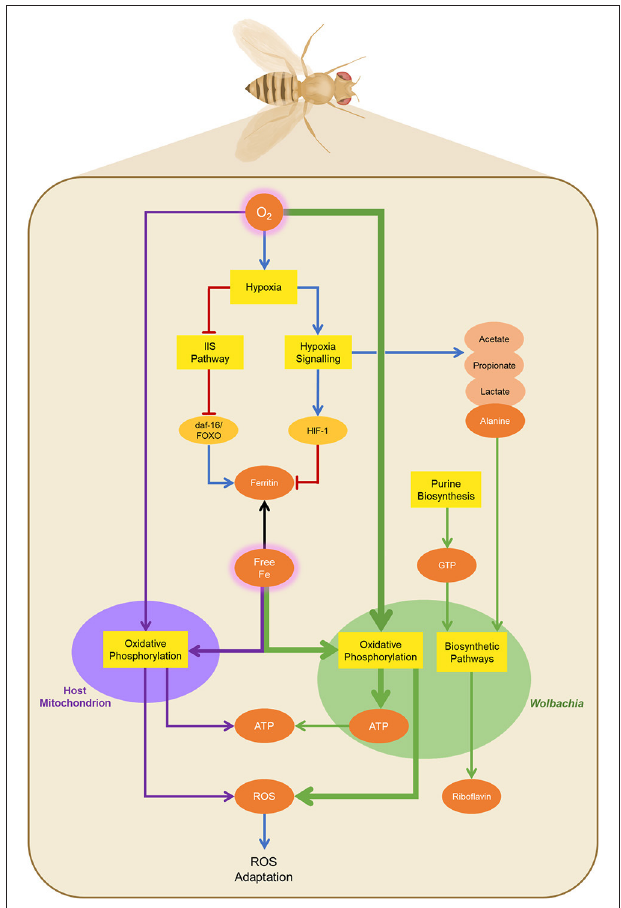
FIGURE 5 | General regulatory and metabolic pathways involved in Wolbachia infection. The presence of Wolbachia (green oval) inside Drosophila cells (beige rectangle) leads to competition for oxygen, causing hypoxia in the host cells. Hypoxia leads to the downregulation of the insulin/insulin-like growth factor signaling (IIS) pathway and upregulation of the hypoxia signaling pathway, and subsequently to reprogramming of mitochondrial metabolism (purple oval). The hypoxia signaling pathway leads to increased bioavailability of free iron in the host cells, as iron sequestration by ferritin is reduced. Iron is redirected to Wolbachia , which relies on the host for iron supply, leading to ROS production as a consequence of oxidative phosphorylation in the symbiont (green arrows). ATP produced by Wolbachia via this route can be exported to the host. The increased bioavailability of iron also leads to ROS production in Drosophila (purple arrows). Both pathways of ROS production lead to the subsequent activation of ROS adaptation mechanisms. In contrast to the oxidative metabolism inside Wolbachia , the hypoxic metabolism in Drosophila leads to the production of end products, such as alanine, lactate, acetate, and propionate, of which alanine is provided to Wolbachia as a precursor for several biosynthetic pathways, as is GTP. Wolbachia also synthesizes riboflavin, which is provided to the host. Black Arrows: general metabolite flow. Purple and green arrows: metabolite flow to/from host mitochondria and Wolbachia , respectively. Blue arrows: Activatory regulation. Red arrows: Inhibitory regulation. Yellow boxes: biochemical modules. Beige ovals: general metabolites. Brown ovals: metabolites involved in provisioning/extraction with Wolbachia